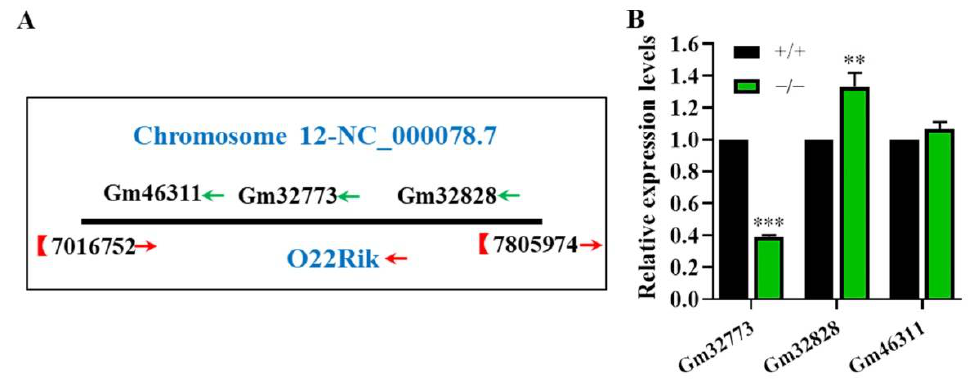
Figure 6. Chromosome location and expression of O22Rik surrounding genes. ( A ) Location diagram of O22Rik adjacent genes Gm46311, Gm32773, and Gm32828 on chromosome 12. ( B ) The expression levels of Gm46311, Gm32773, and Gm32828 in WT and O22Rik. Gene expression was analyzed by qPCR. Data are the mean ± SEM ( n = 3). ** p < 0.01 and *** p < 0.001 compared with WT mice.